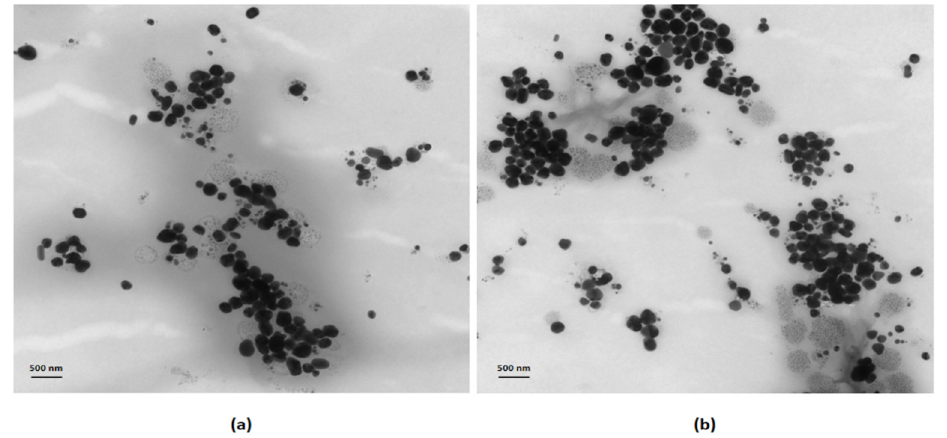
Figure 2. TEM images of: ( a ) the silver nanocolloids loaded with betulinic acid, ( b ) the PEGylated silver nanocolloids loaded with betulinic acid. Scale bars are 500 nm.